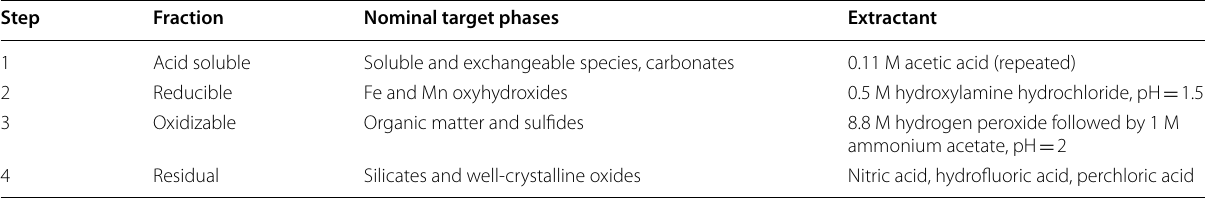
Table 1 Overview of the sequential extraction procedure with nominal target phases Step